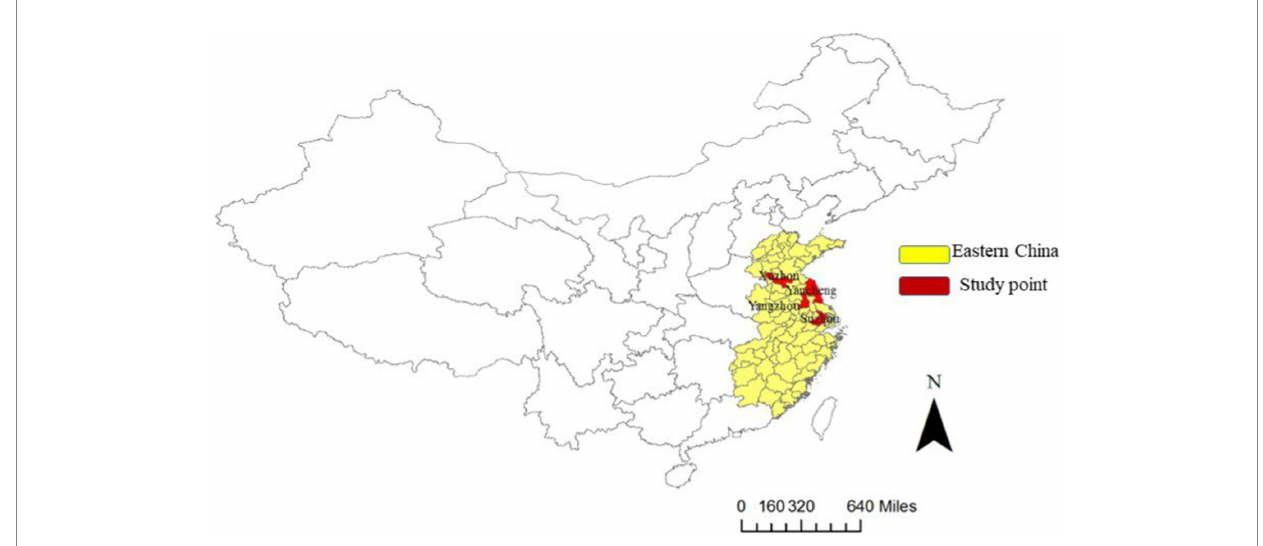
FIGURE 1 Map of China and the location of the Eastern China Student Health and Wellbeing Cohort Study, including Pei county, Yizheng city, Changshu city, and Dongtai